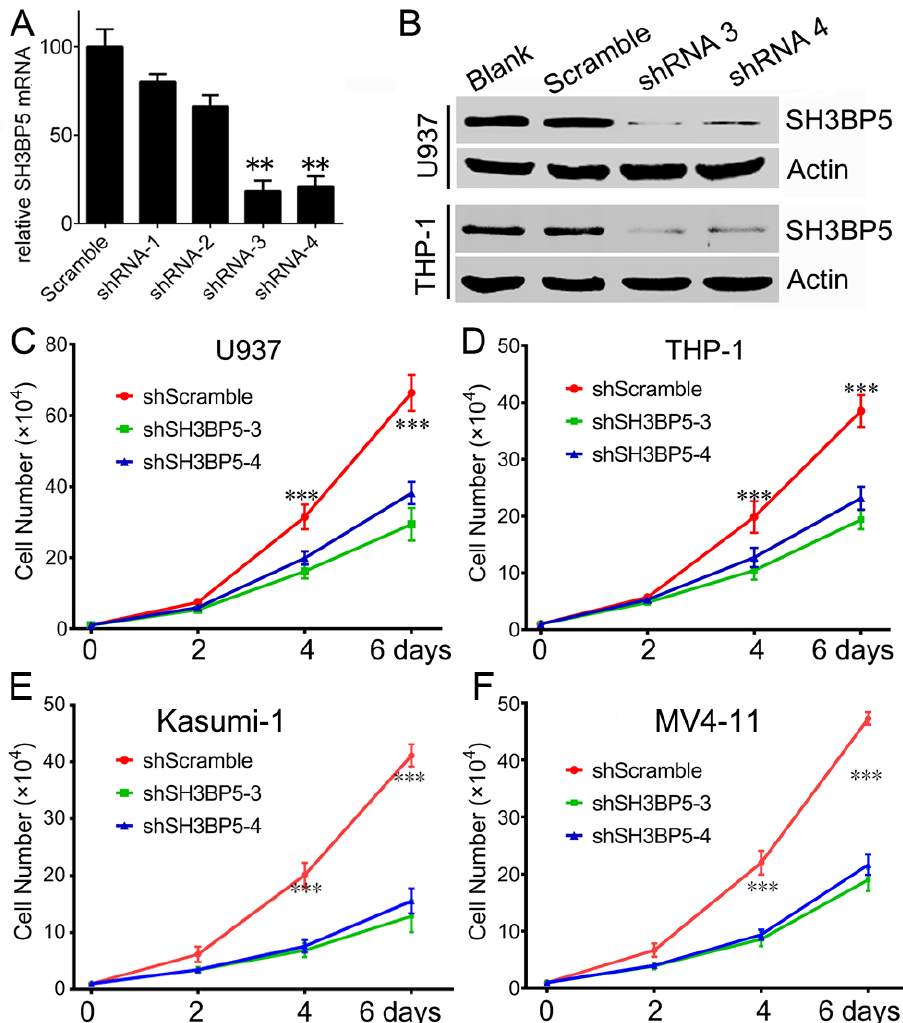
Figure 4. Knockdown of SH3BP5 expression suppresses growth of U937 and THP-1 cells. ( A ) U937 cells were infected with SH3BP5 or scramble shRNA for 24 h followed by RT-PCR analysis transcription of SH3BP5. N = 5, **, p < 0.01 compared to scramble shRNA group. ( B ) U937 or THP-1 cells were infected with indicated shRNAs for 72 h followed by western blot analysis expression of SH3BP5. ( C – F ) Cell numbers of U937, THP-1, Kasumi-1, and MV4-11, at 2, 4, and 6 days post-infection, with indicated shRNA. N = 3, ***, p < 0.005 compared with the SH3BP5 shRNA groups.